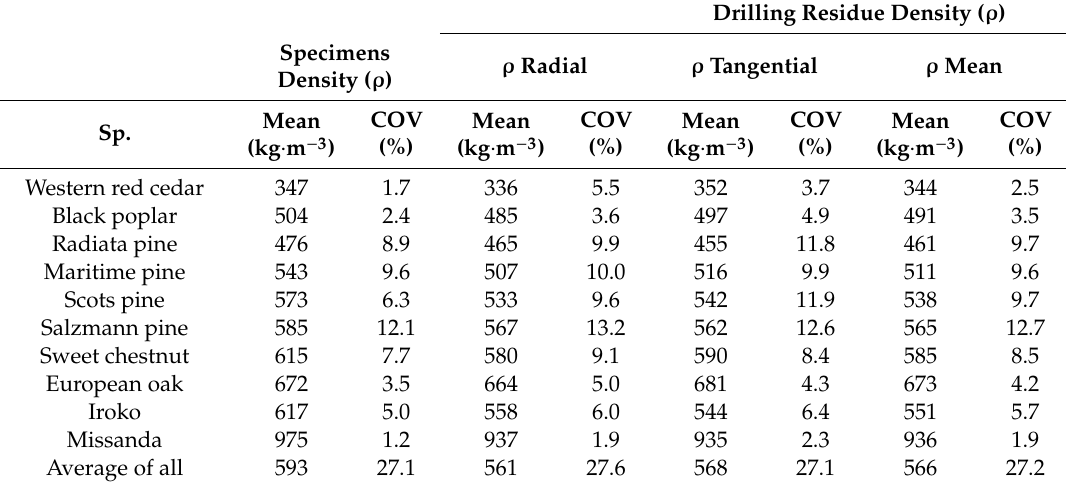
Table 2. Average densities of specimens and drilling residue.